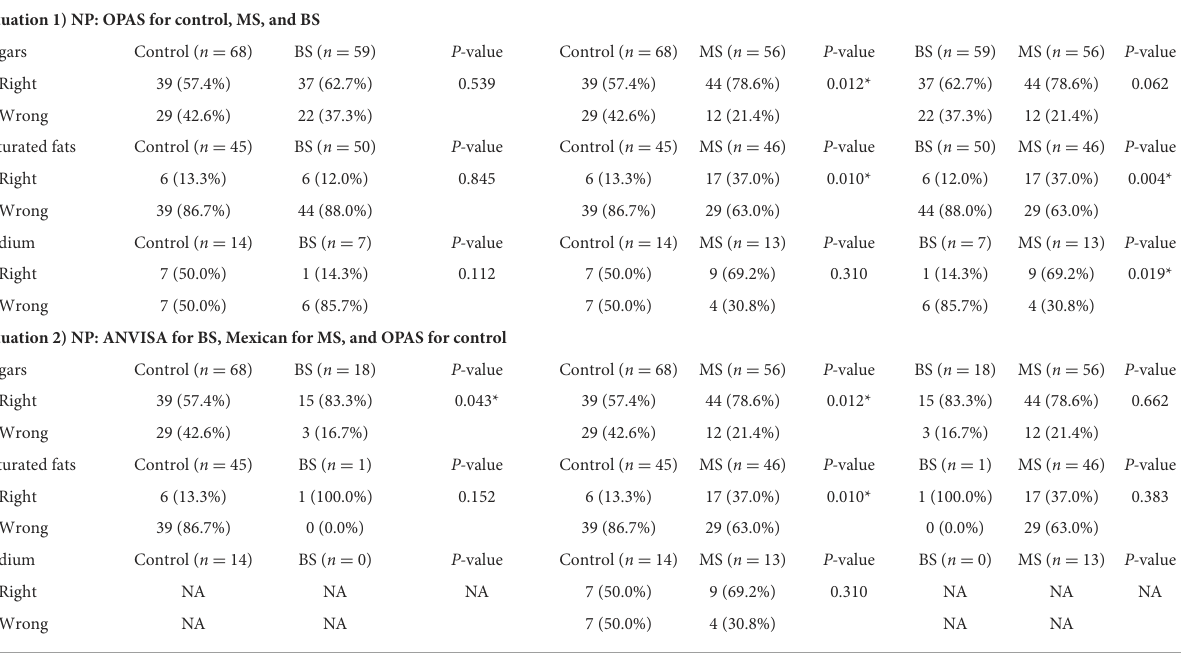
TABLE 7 Right and wrong answers about excessive nutrients, by study arm, considering different nutritional profile models. In your opinion, does the scanned product contain any excessive nutrients or any substance that could harm a healthy diet?